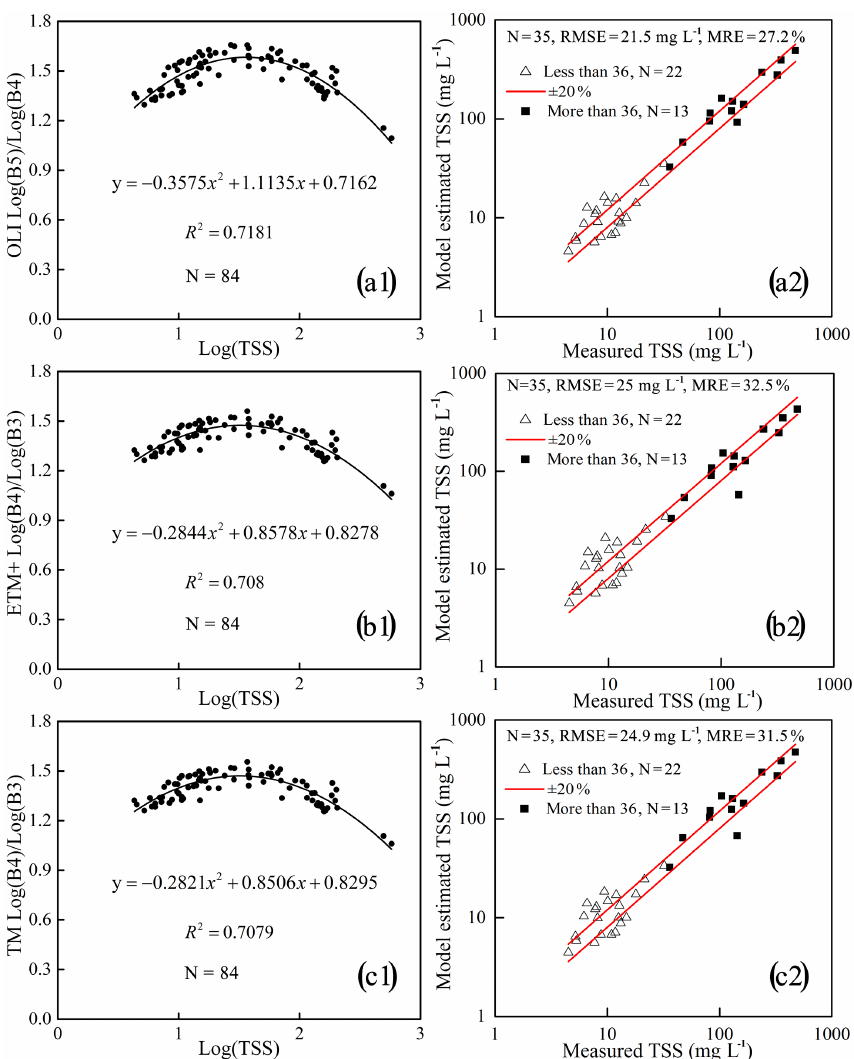
Figure 4. The calibration and validation results of TSS retrieval models: based on 119 in situ data for (a) OLI, (b) ETM + and (c) TM.